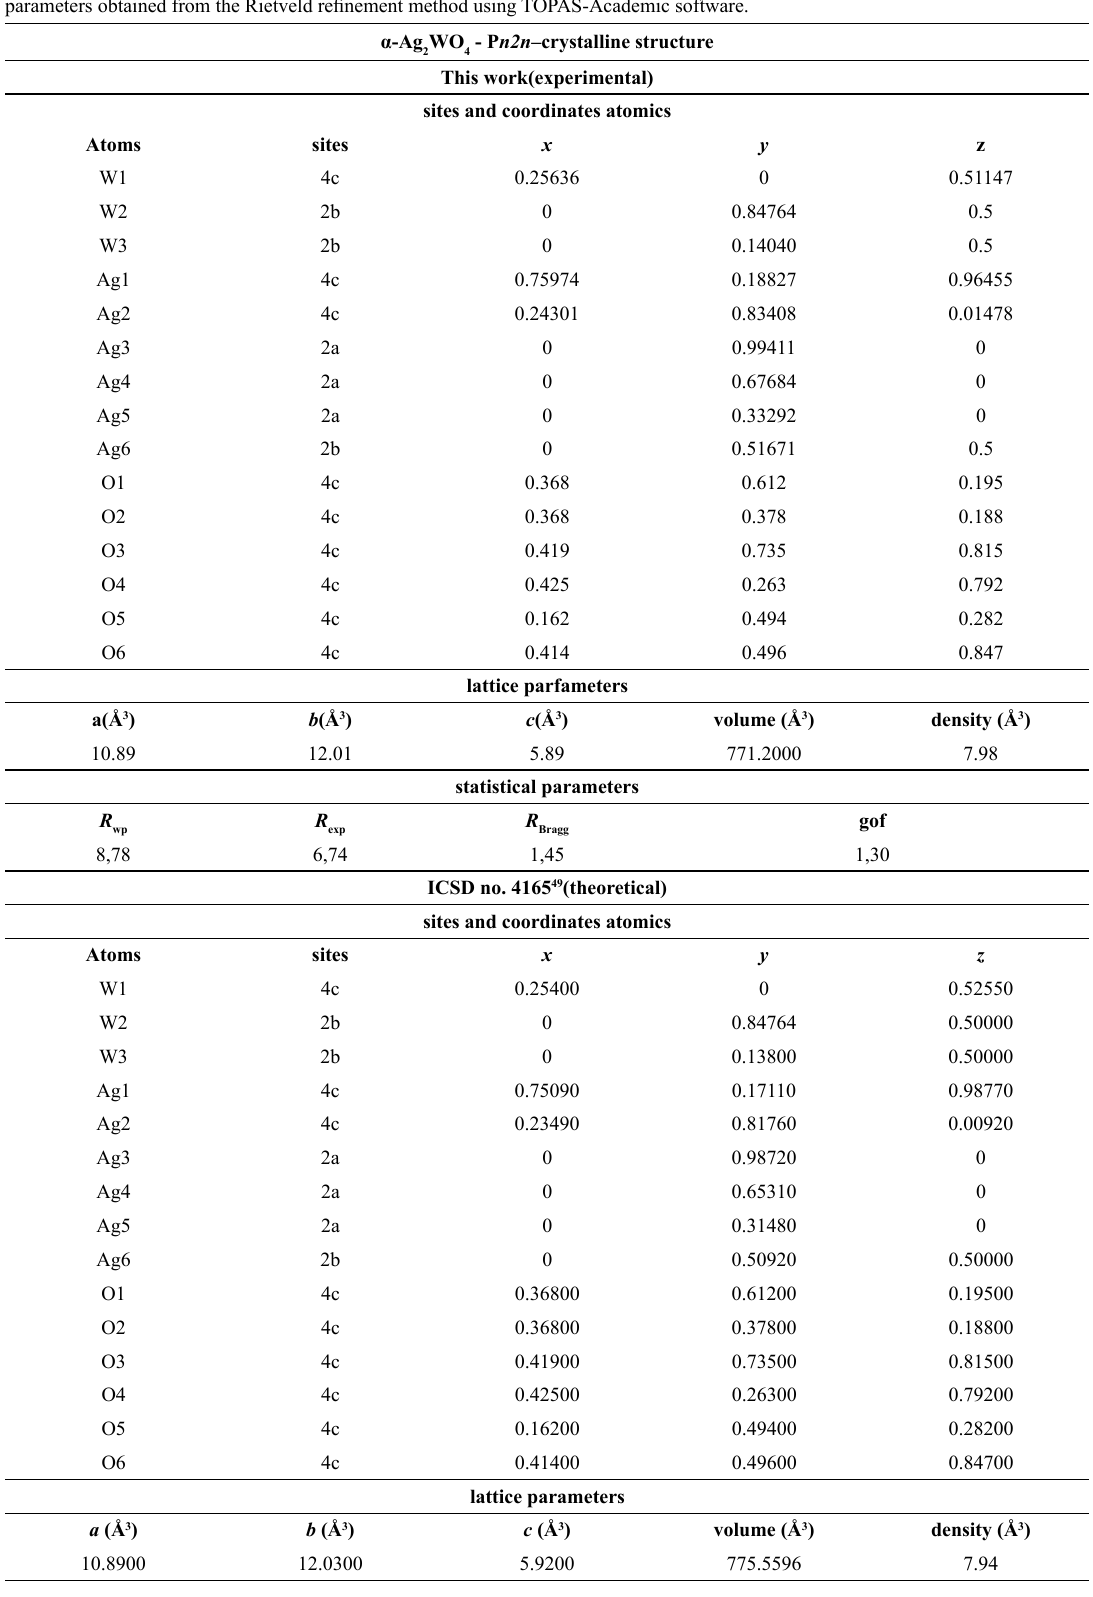
WO nanostructures and statistical 2 4